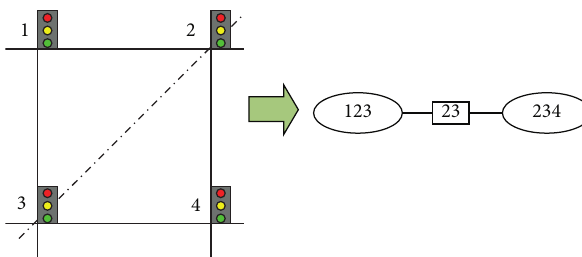
Figure 3: Virtual road networks and the corresponding junction